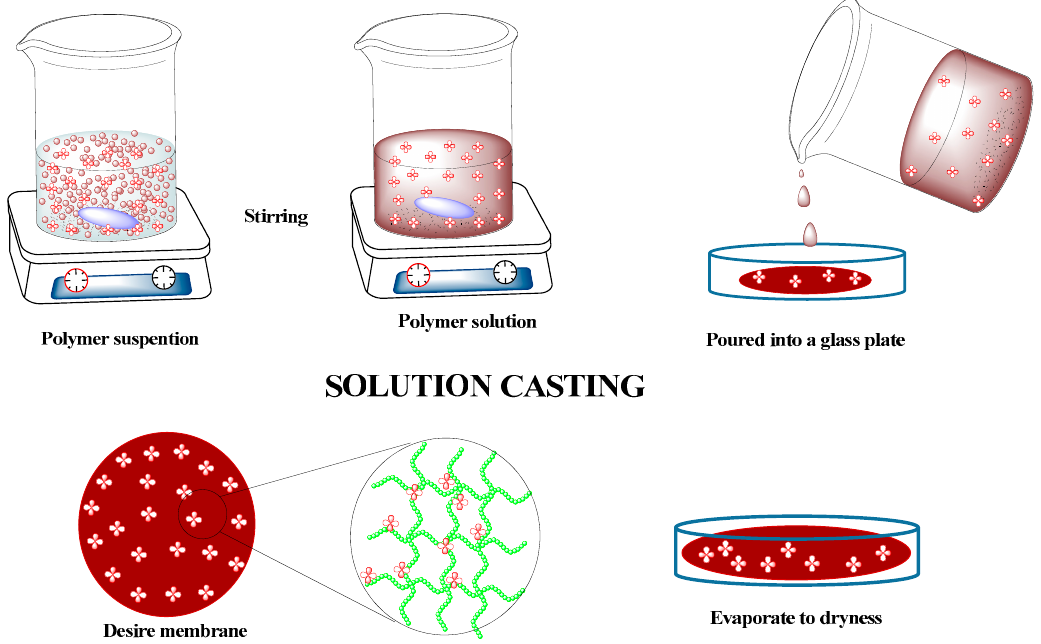
Figure 1. Preparation of Nanocomposite Membrane (NCM) by solution casting method.